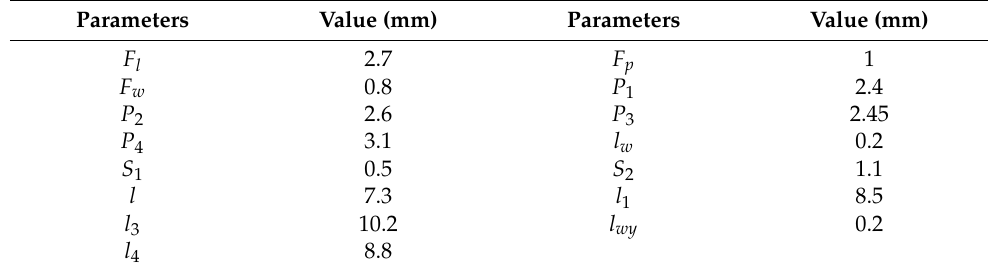
Figure 1. The 5 × 5 interconnected ME dipole antenna array configuration. Table 1. Interconnected ME dipole antenna array. Table 1. Interconnected ME dipole antenna array.